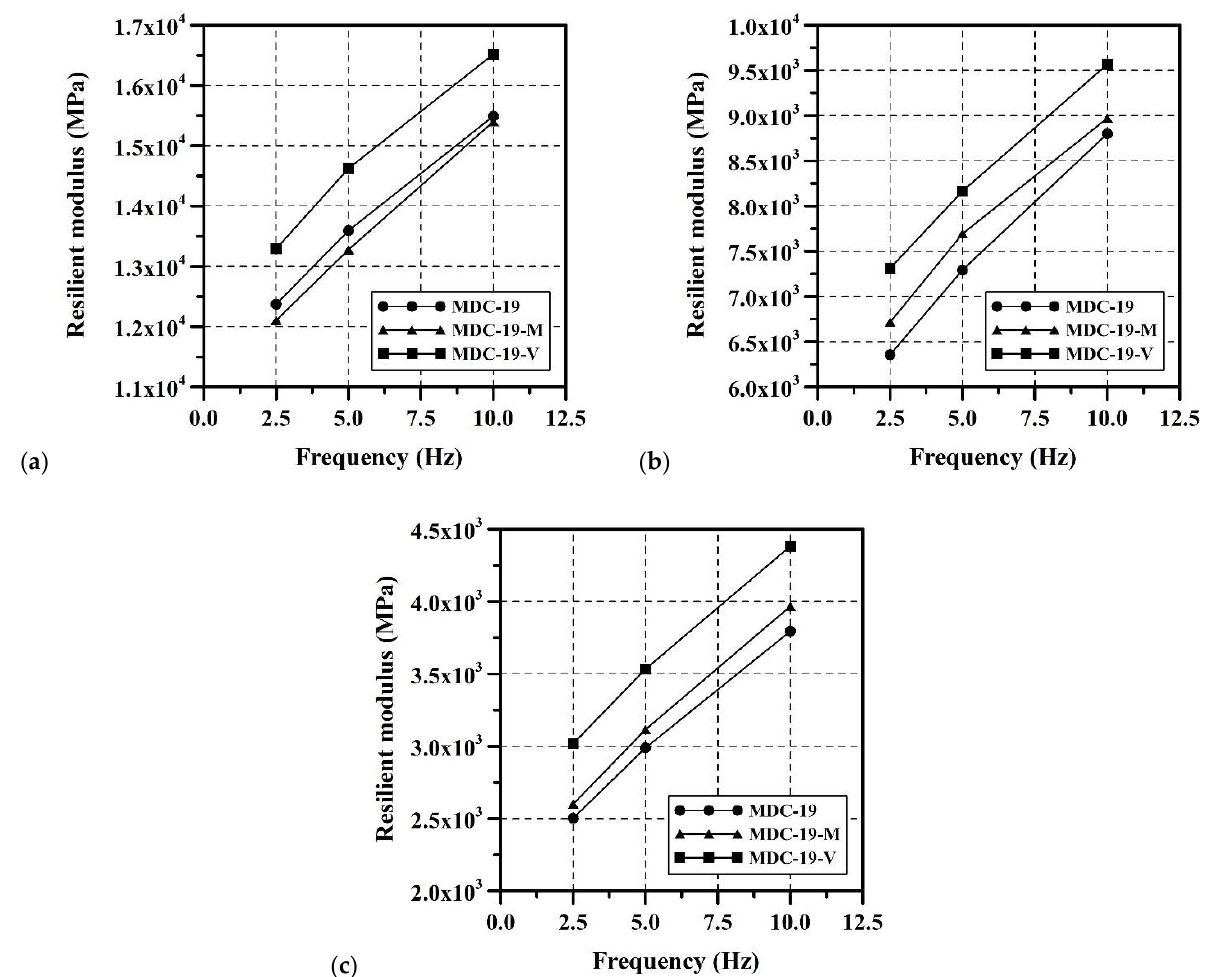
Figure 5. Resilient modulus MDC-19, MDC-19-M, and MDC-19-V: ( a ) 10 °C; ( b ) 20 °C; ( c ) 30 °C.